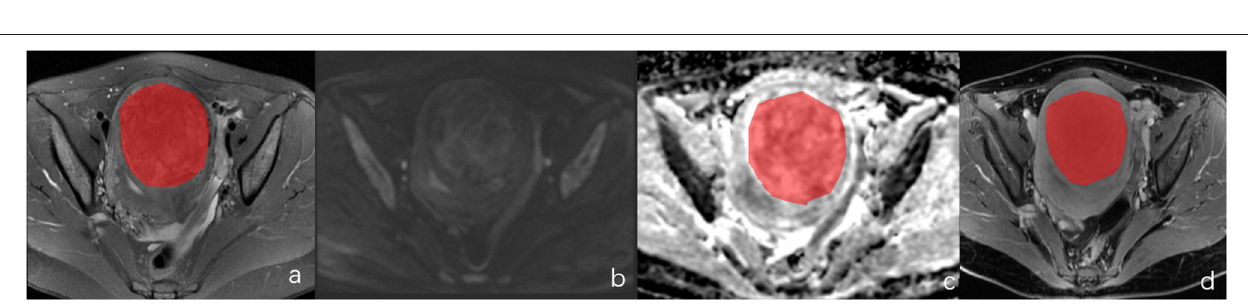
FIGURE 2 | A female of 46 years with degenerative hysteromyoma. (a–d) represented the localization of the lesion on DWI and the ROI selection schematic for T2WI, ADC and T1CE,